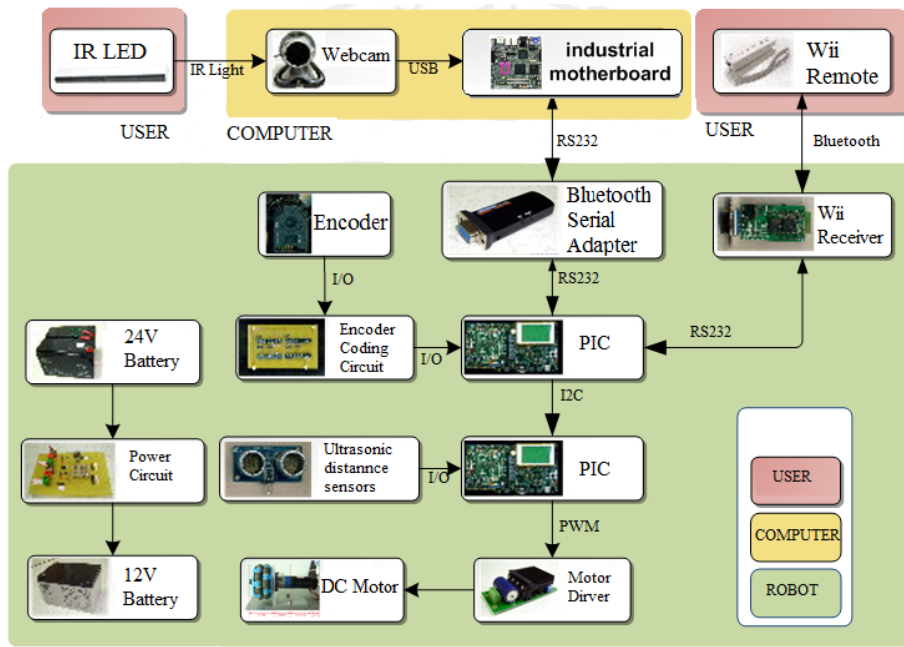
Figure 2. The robot system hardware link.